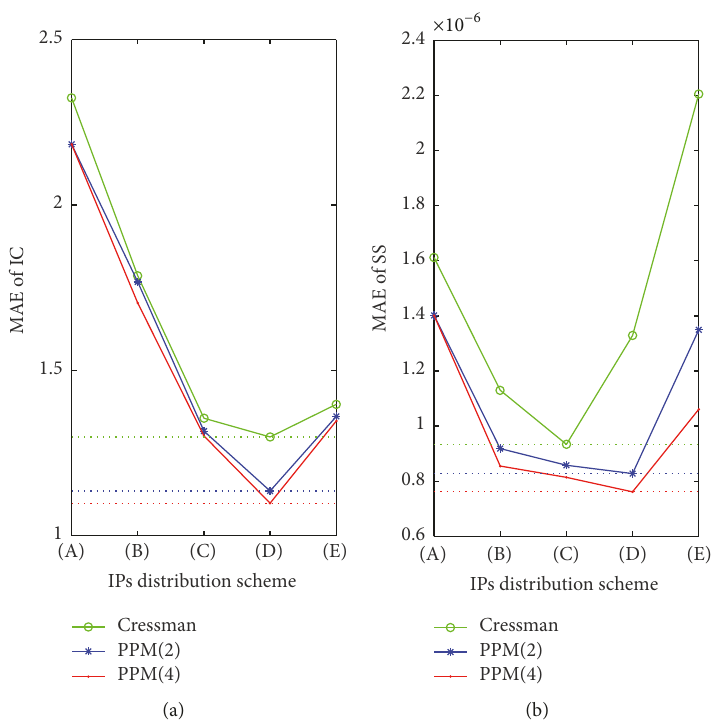
Figure 2: (a) The MAE of the IC versus the IPs distribution schemes in Group One. (b) The MAE of SS versus the IPs distribution schemes in Group One. The abscissa indicates distribution scheme category of IPs, while the ordinate indicates the MAE of inversion results. The solid lines are values of the given interpolations and the dotted lines indicate the minimum values of the solid lines, respectively.